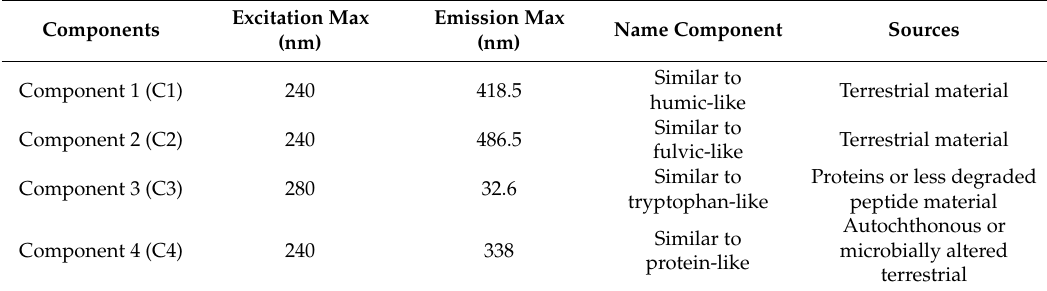
Table 2. Maximum excitation and emission wavelengths of four components identified by the parallel factor analysis (PARAFAC) model and their